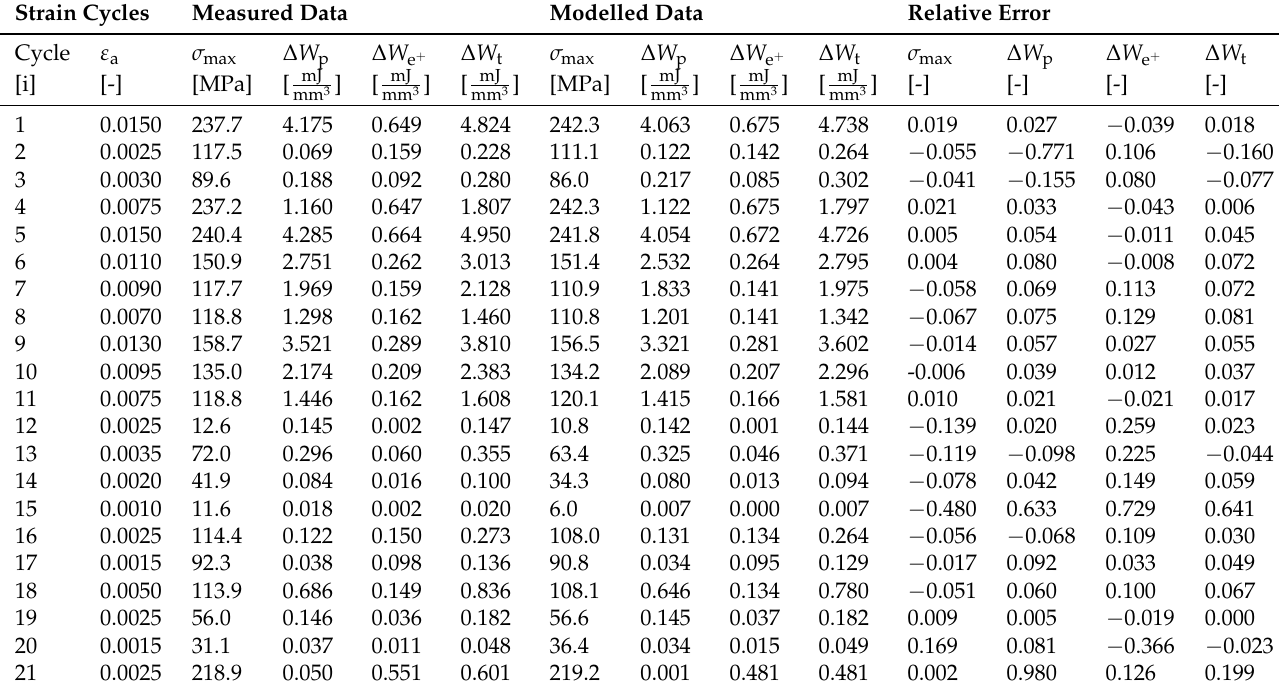
Table 3. Comparison of measured and modelled strain energy densities–variable strain history